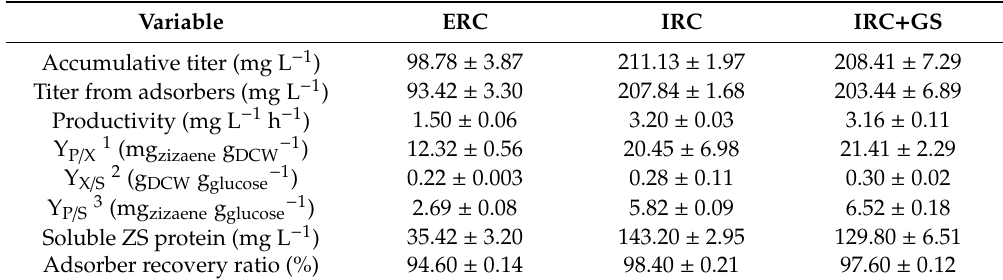
Figure 10. Accumulative production of (+)-zizaene at 2 L bioreactors by distinct in situ recovery configurations: External extraction (ERC), internal extraction (IRC), and internal extraction with gas stripping (IRC+GS). Data are the means of three sample replicates with error bars as SD. Table 1. Comparison of the bioprocess-performance variables between distinct bioreactor configurations for the in situ recovery of (+)-zizaene after 72 h of growth.